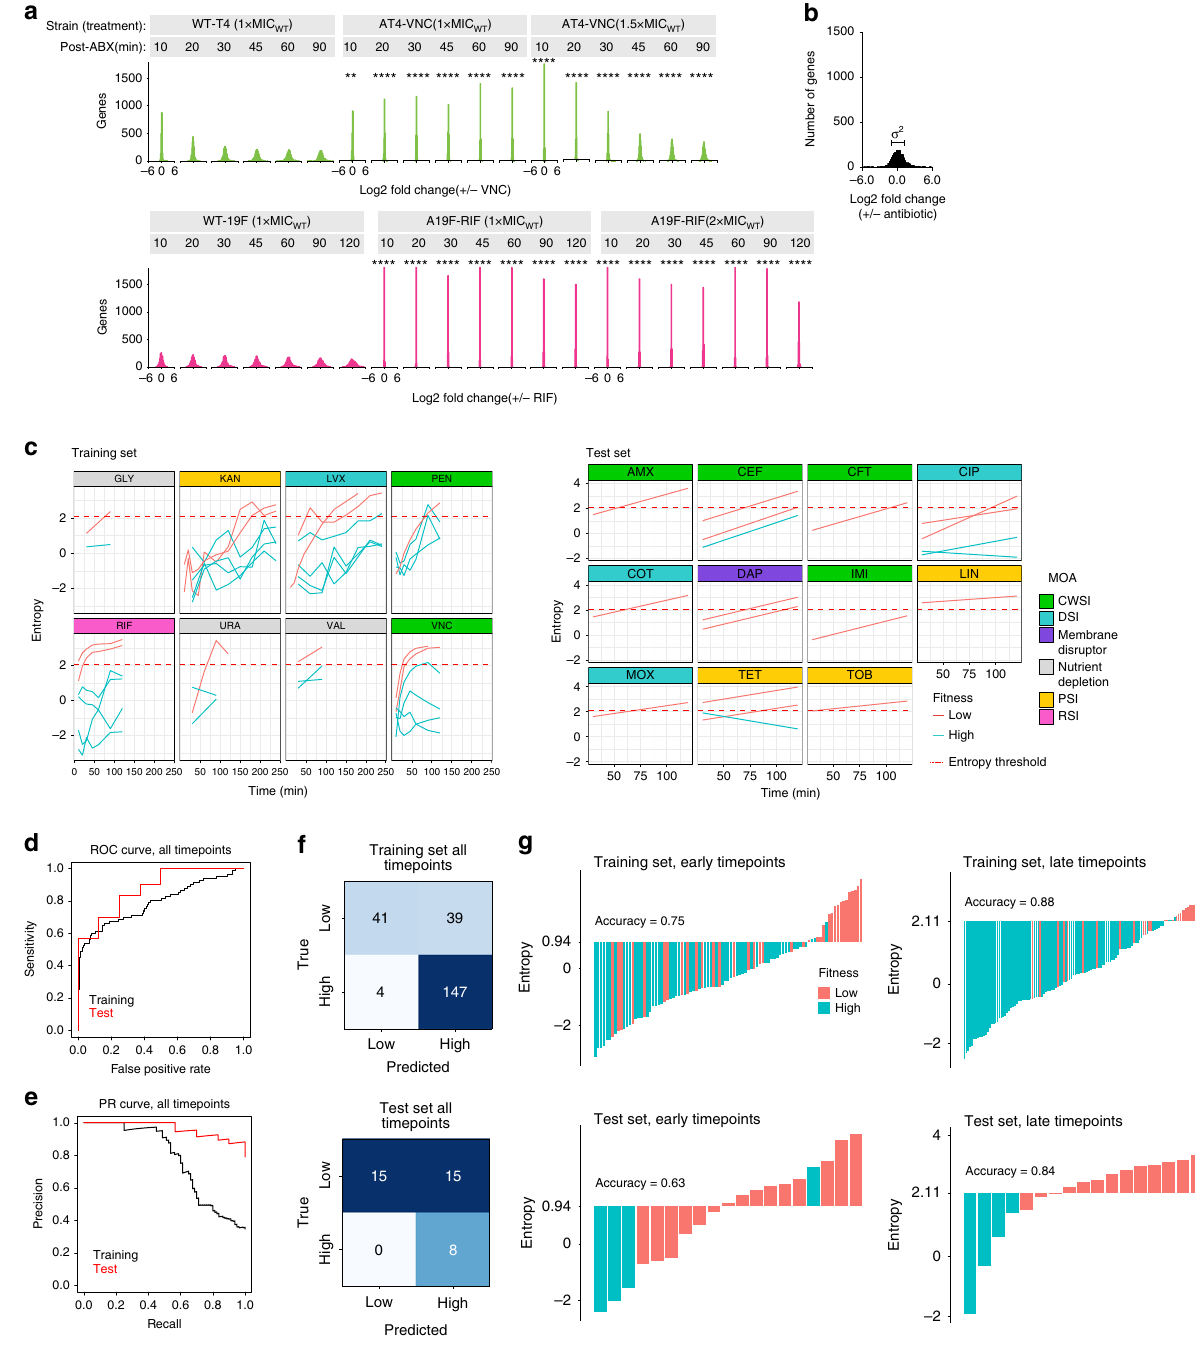
mL cipro fl oxacin triggering expression changes with higher var- iance from bacterial cultures having low fi tness ( S. typhimurium and S. pneumoniae serotype 1), compared to those with high fi tness ( S. pneumoniae serotype 23F, E. coli and K. pneumoniae ) (Fig. 5b). Single-timepoint entropy was computed for the tran- scriptome of each of these previously unseen isolates. Impor- tantly, with the original threshold of 2.08, which was determined during model training with data from S. pneumoniae in Fig. 4, fi tness outcomes could be predicted for the new organisms with 100% accuracy, indicating that the single-timepoint entropy measure, which uses the least amount of data compared to other variants of entropy, is a species-independent generalizable feature for fi tness